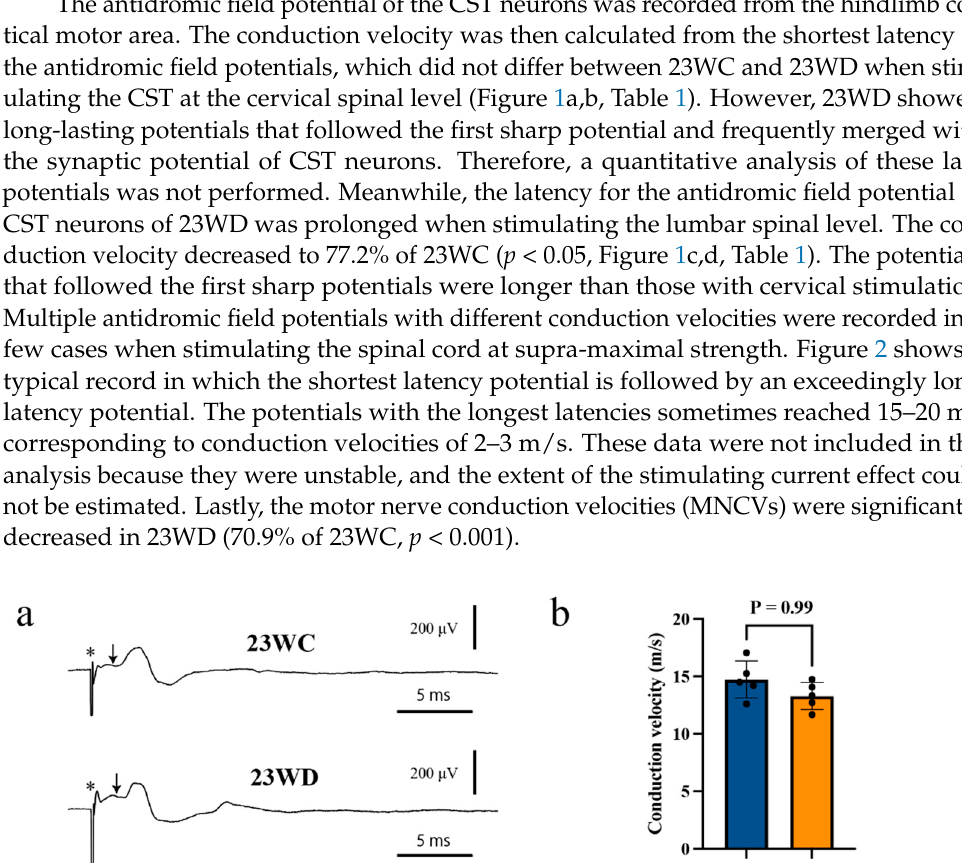
Abbreviations: BDF, base of the dorsal funiculus; 23WC, control animals at 23 weeks after sham diabetes induction; 23WD, diabetic animals at 23 weeks after diabetes induction; CST, corticospinal tract.